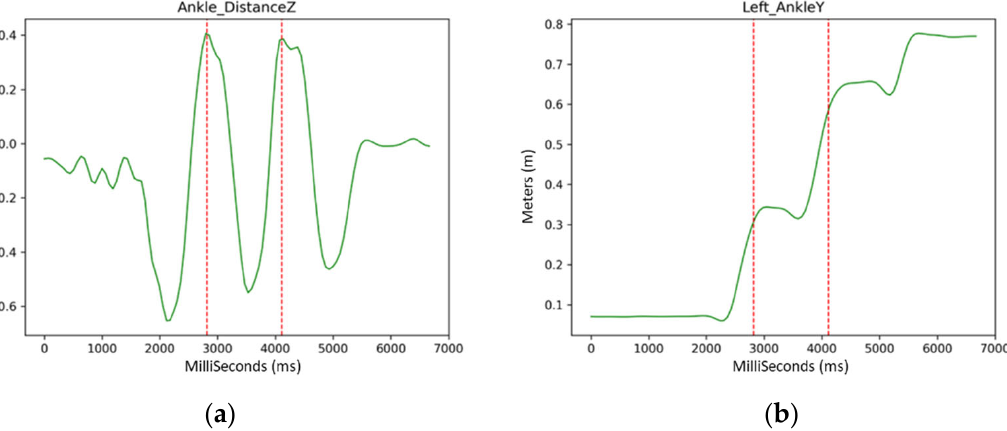
Figure 6. SANE’s gait detection (red vertical lines) via the projection on Z of the trend related to the Ankle Distance: ( a ) Ankle Distance trend; ( b ) an example of a key point signal (the projection on X of the signal related to the Right Ankle joint) cut within the time range associated with the gait detection.